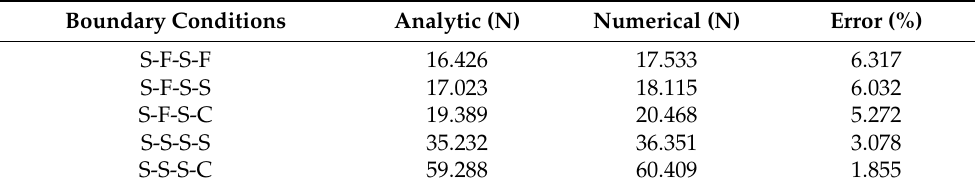
Table 1. Comparison of critical buckling load for different boundary conditions.